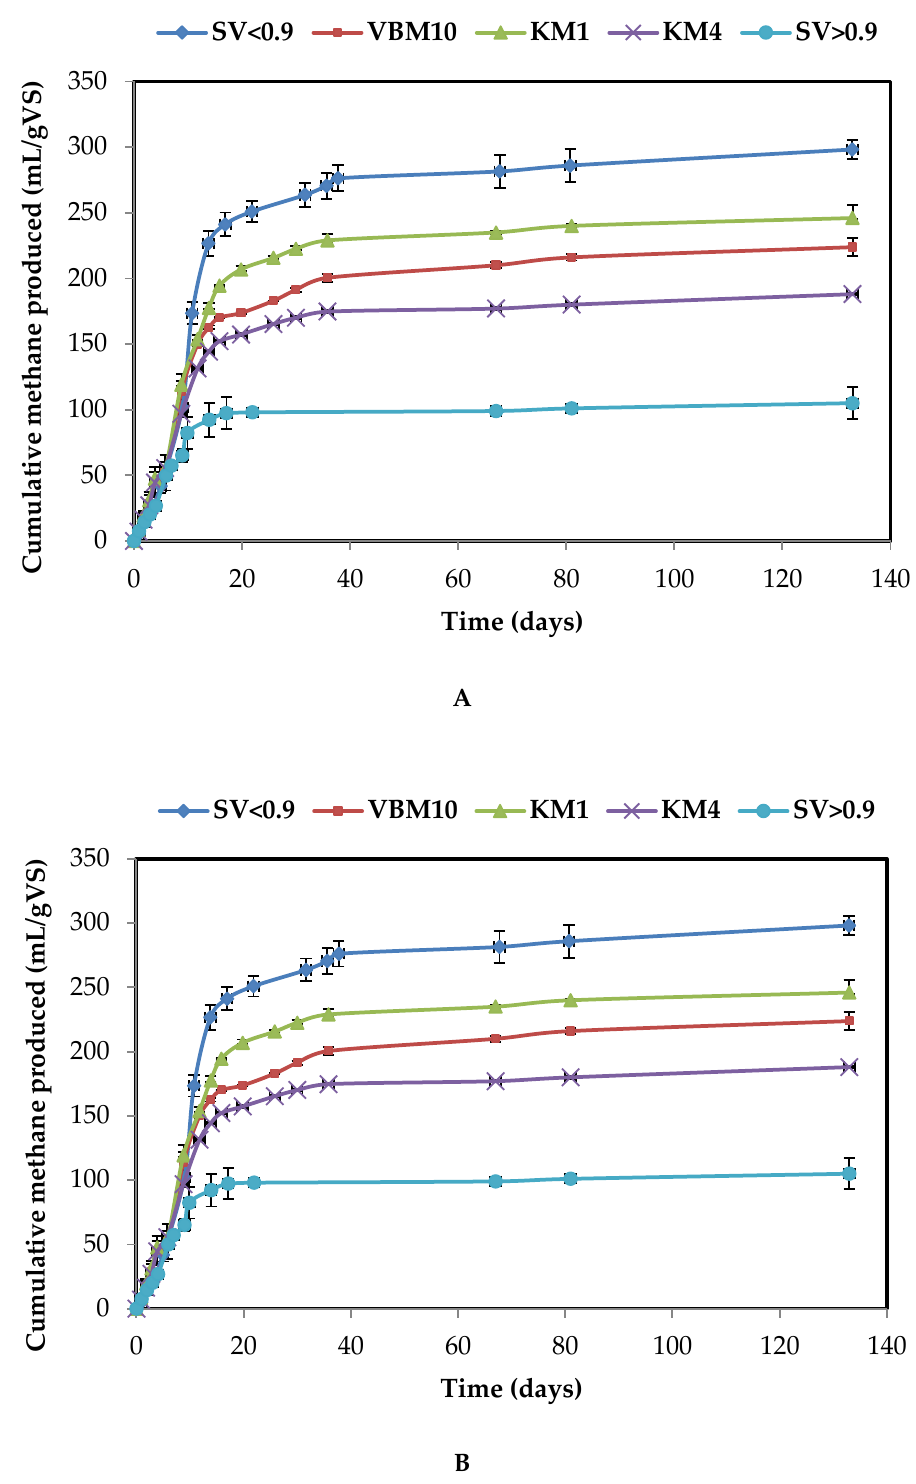
Figure 4. Cumulative methane production for different dry fractionation process of T olive pomace from three-phase extraction process: ( A ) Milling pretreatments and ( B ) dry separation process (electrostatic and sieving).